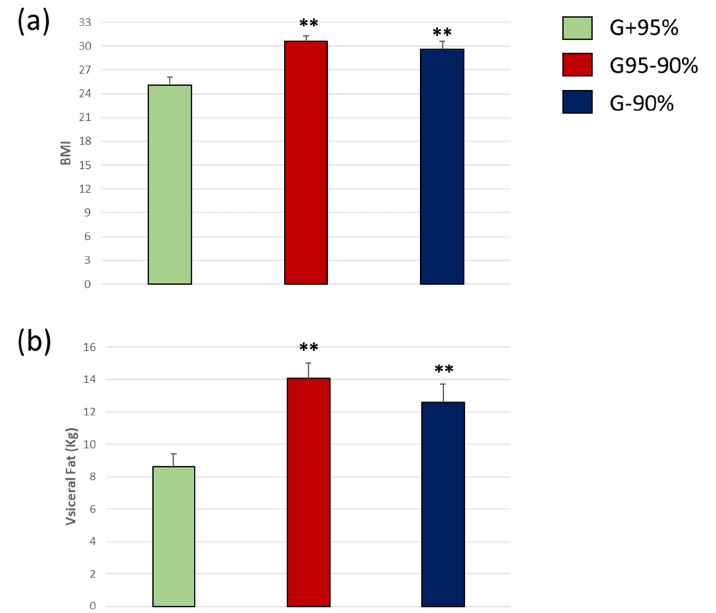
Figure 1. Body mass index ( a ) and visceral fat ( b ) in people older than 60 years with different mental agility conservation. ** p < 0.01 vs. G + 95%. p -values for BMI: G + 95% vs. G95 − 90% p = 0.000, G + 95% vs. G − 90% p = 0.003 and G95 − 90% vs. G − 90% p = 0.433; Visceral Fat (kg): G + 95% vs. G95 − 90% p = 0.000, G + 95% vs. G − 90% p = 0.010 and G95 − 90% vs. G − 90% p = 0.332. Biomedicines 2023 , 11 , x FOR PEER REVIEW